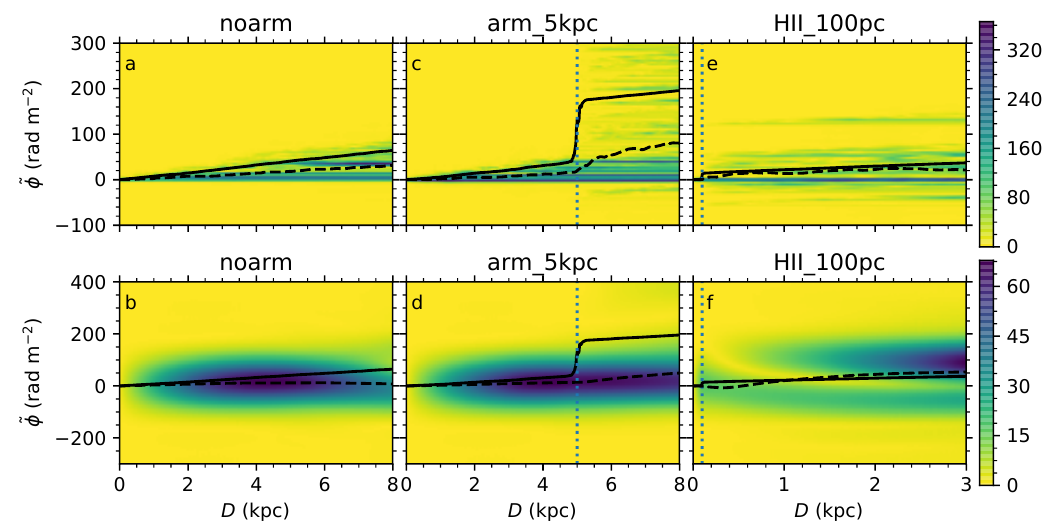
Figure 6. Faraday depth spectra as a function of D as measured in the GMIMS-LBS frequency band ( a,c,e ) and the GMIMS-HBN frequency band ( b,d,f ). The simulated polarized intensity in K is indicated with the color bars. Solid lines show φ integrated to s = D ; dashed lines show the first moment of the Faraday depth spectra. Dotted vertical lines show the position of the arm in each model.